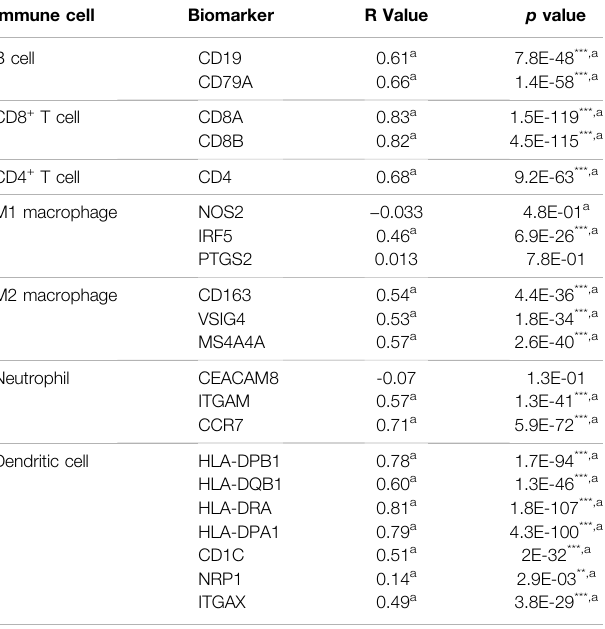
TABLE 2| Correlation analysisbetweenFAT10and biomarkersofimmune cellsin SKCM via GEPIA database. Immune cell